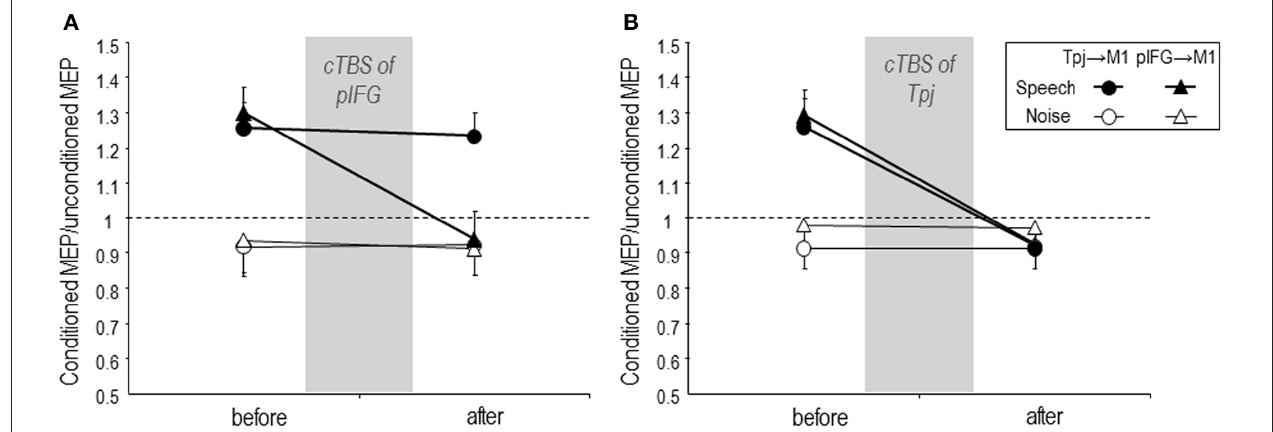
FIGURE 2 | Mean task-related Tpj → M1 (circle) and pIFG → M1 (triangle) effective connectivity during listening to speech (filled symbols) or to white noise (control condition, open symbols) before and 5min after cTBS over the pIFG (A) or over the Tpj (B). (A) cTBS of the pIFG abolished speech task-related increase of pIFG → M1 effective